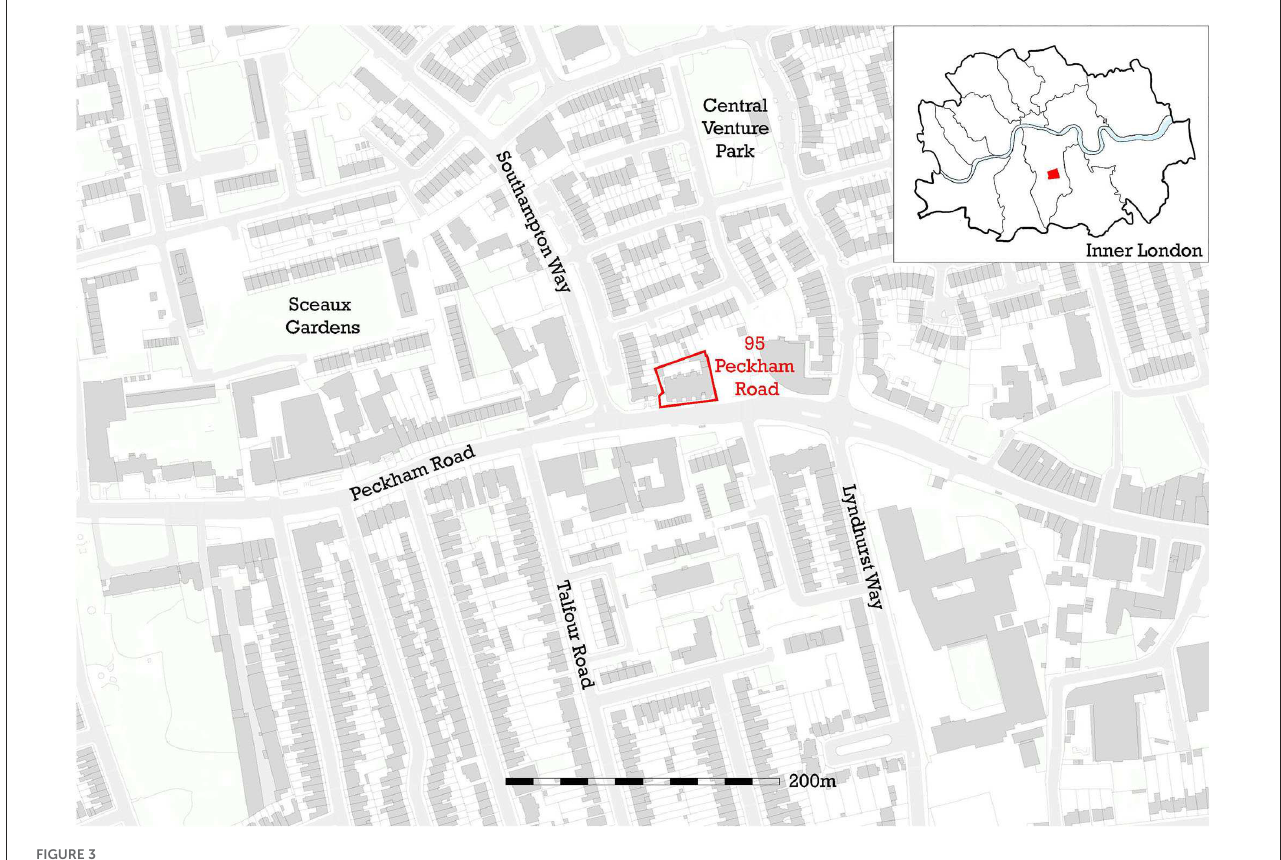
FIGURE3 Location of 95 Peckham